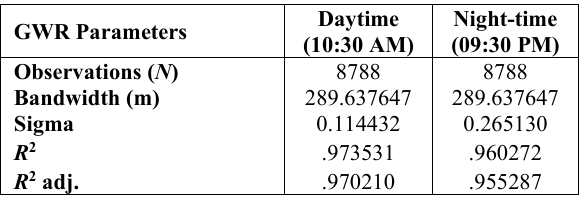
Table 2. GWR model parameters for both daytime and night-